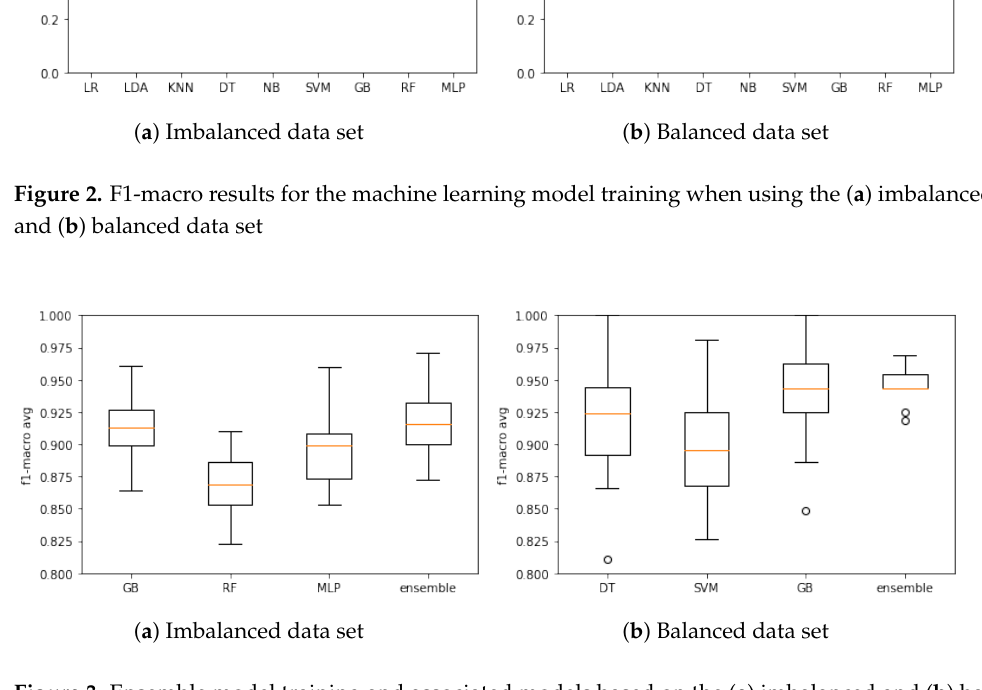
Figure 3. Ensemble model training and associated models based on the ( a ) imbalanced and ( b ) bal- anced data. sets.